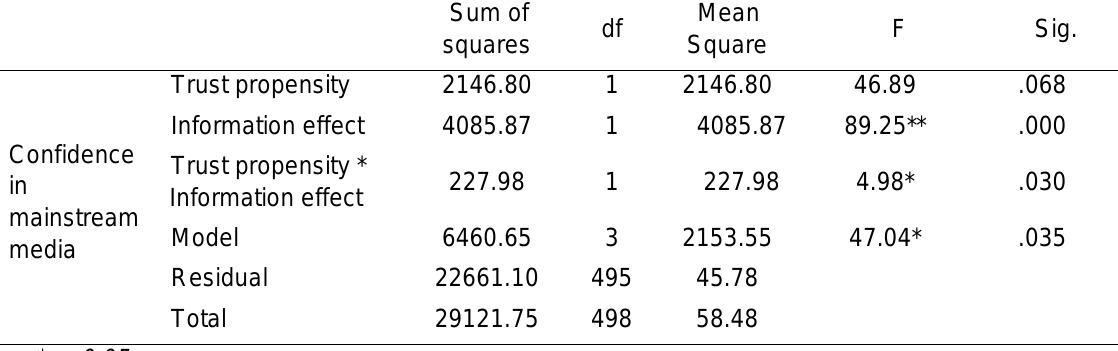
Table 2: Confidence in mainstream media by trust propensity and information effect Sum of